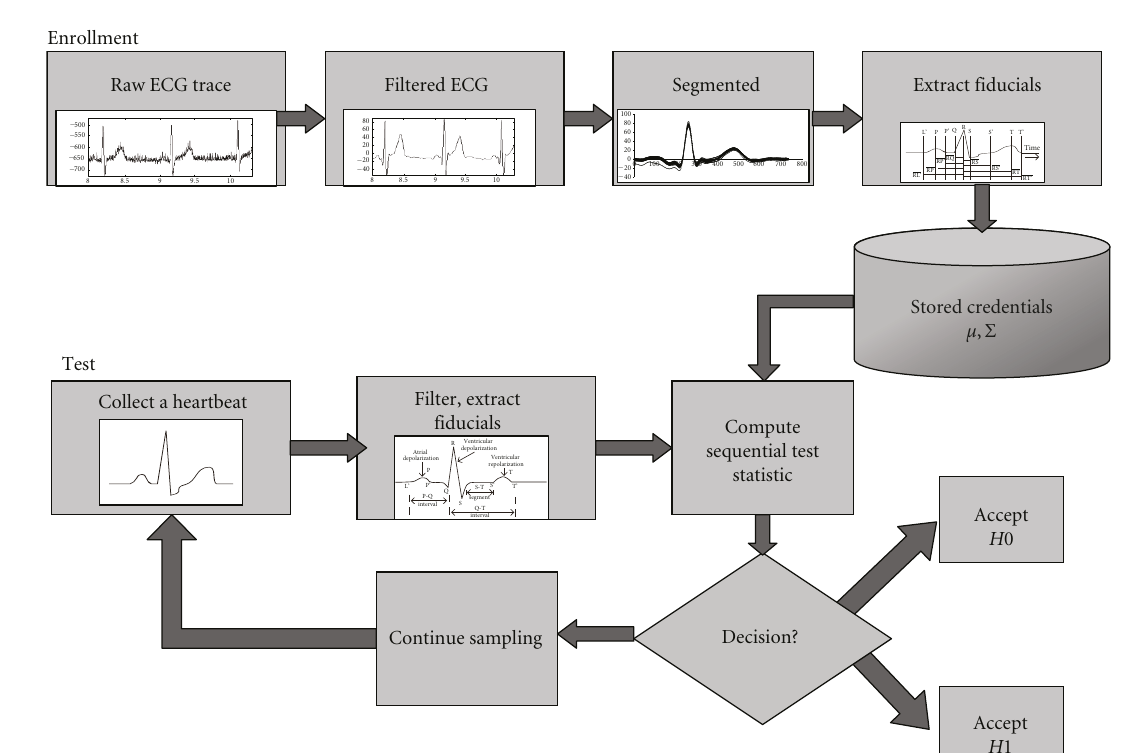
Figure 3: Signal processing for the sequential